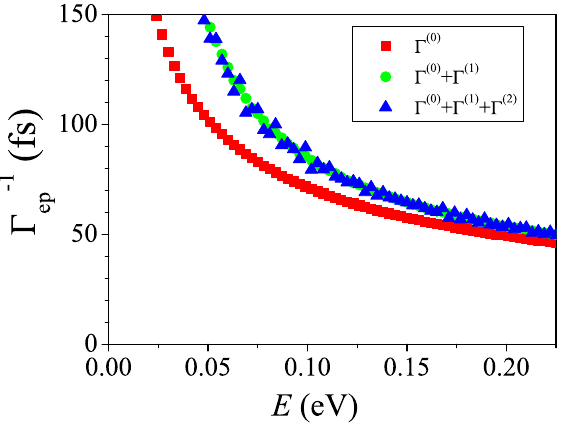
Figure 12. Time constant by the elastic Γ -L e-ph transition, including the non-Condon effect, is